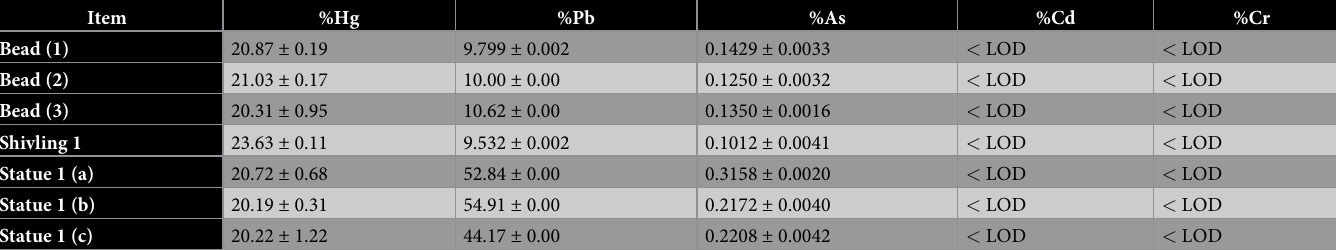
Table 2. Determination of Hg, Cd, Cr, Pb, and As in select parad objects (% ±